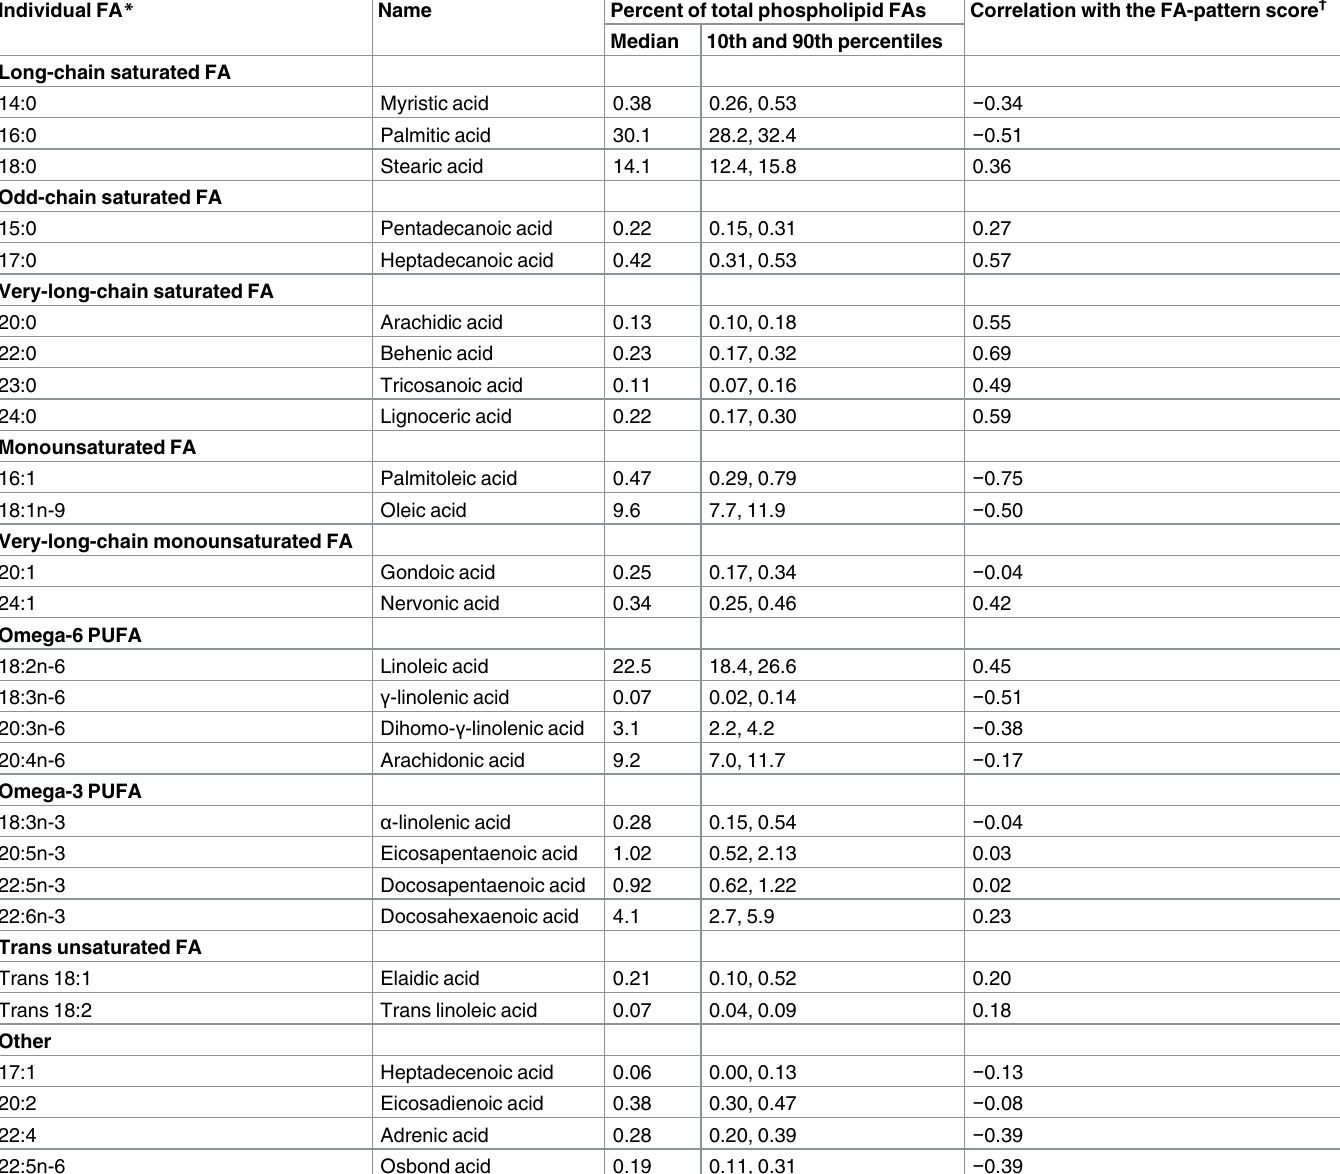
Table 1. Relative concentrations of plasma phospholipid fatty acids and their correlations with the identified fatty acid pattern score: EPIC-Inter- Act sub-cohort ( n = 15,919). Individual FA * Name